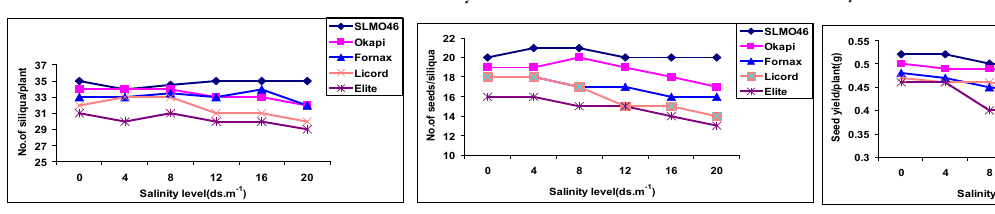
Fig. 3. Days to maturity performance of five canola cultivars under different salin- ity levels